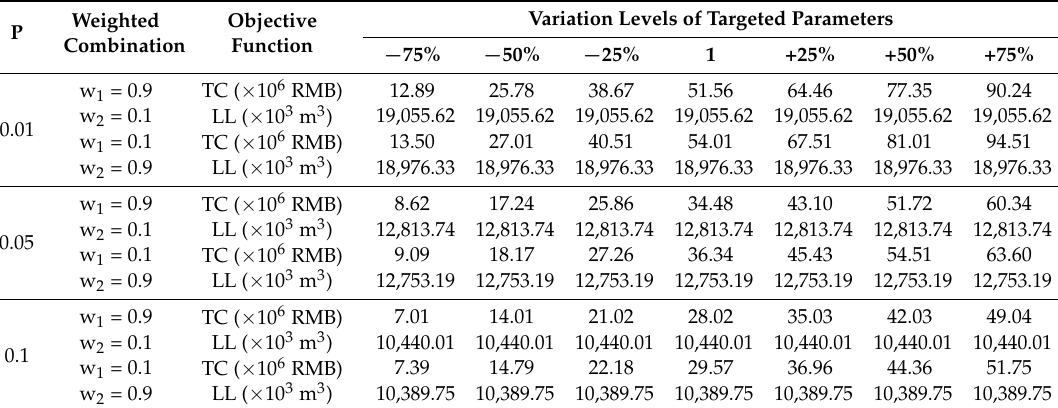
Table 6. The demonstration of cost variation affecting the model